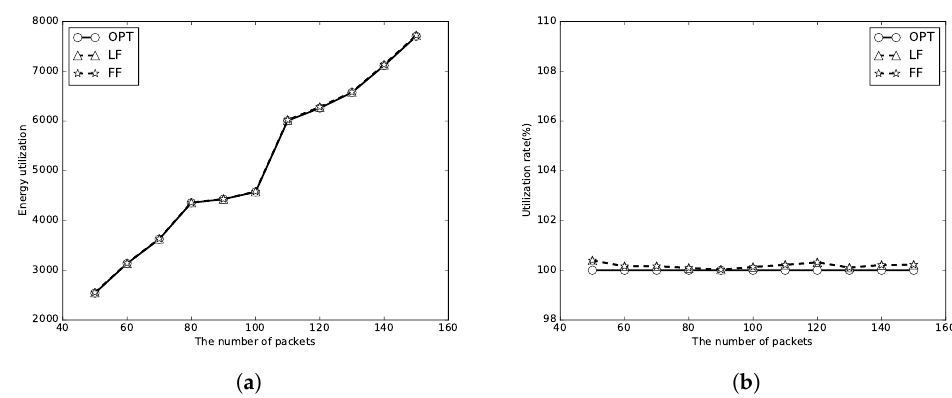
Figure 10. C = 10 E . ( a ) energy utilization; ( b ) energy utilization